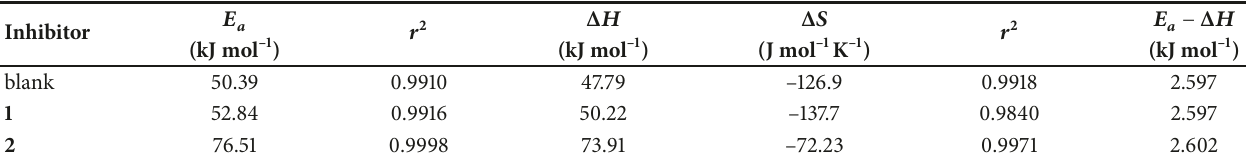
Table 6: Thermodynamic parameters of corrosion inhibition process of carbon steel in 1.0mol L – 1 HCl solution in absence and presence of inhibitors.